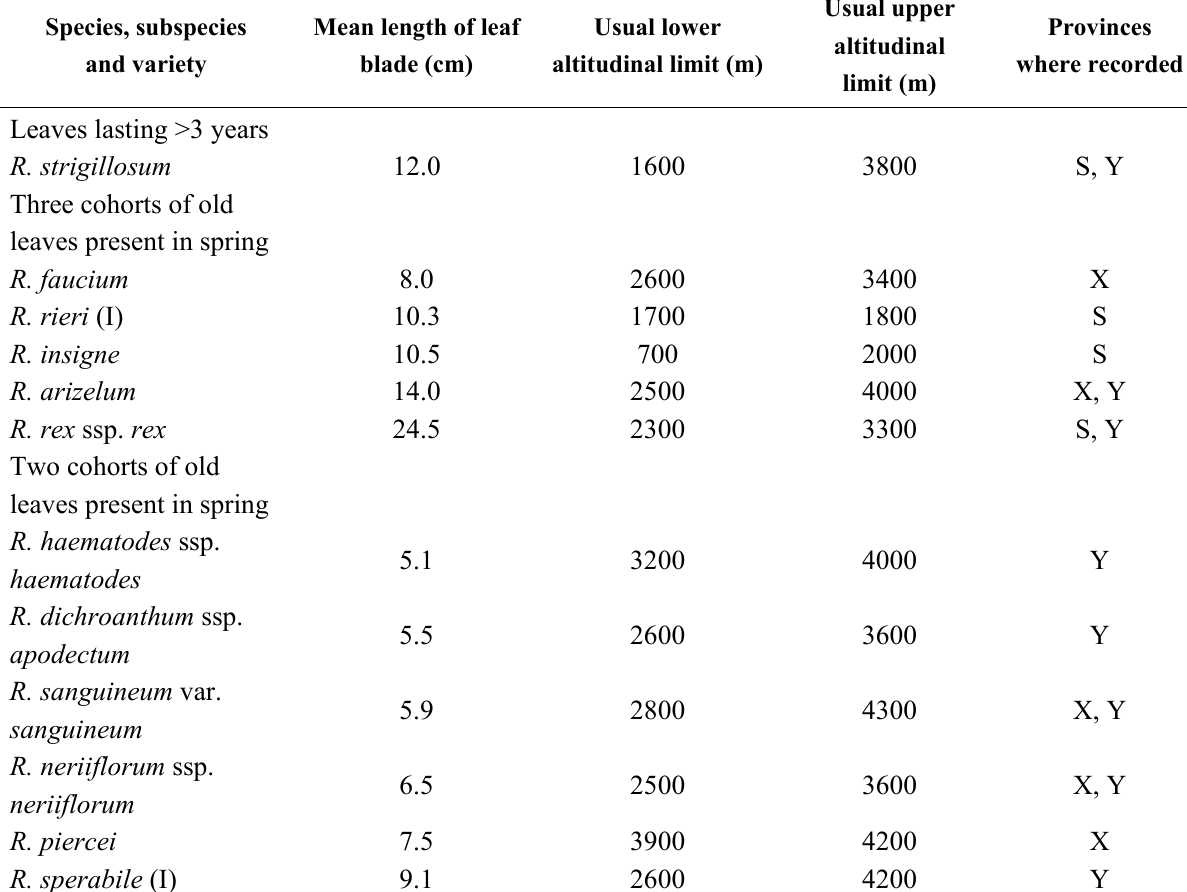
Table 5. The normal maximum longevity of leaves of Rhododendron species from SW China growing at Benmore (most species) and/or Inverleith, based on observations made on June 2–3, 2009, together with mean leaf blade lengths and distributions taken from Fang et al. [24]; (BI), studied at Benmore and Inverleith; (I), studied at Inverleith;